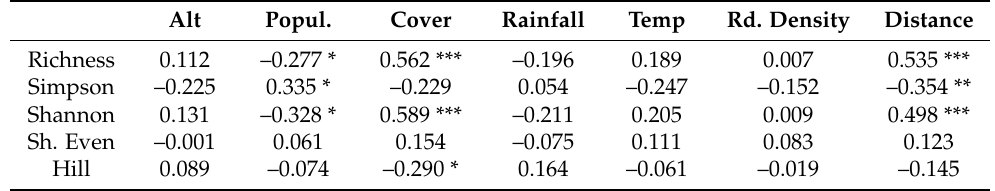
Table 4. Simple linear correlation coefficient between diversity indices and environmental factors.